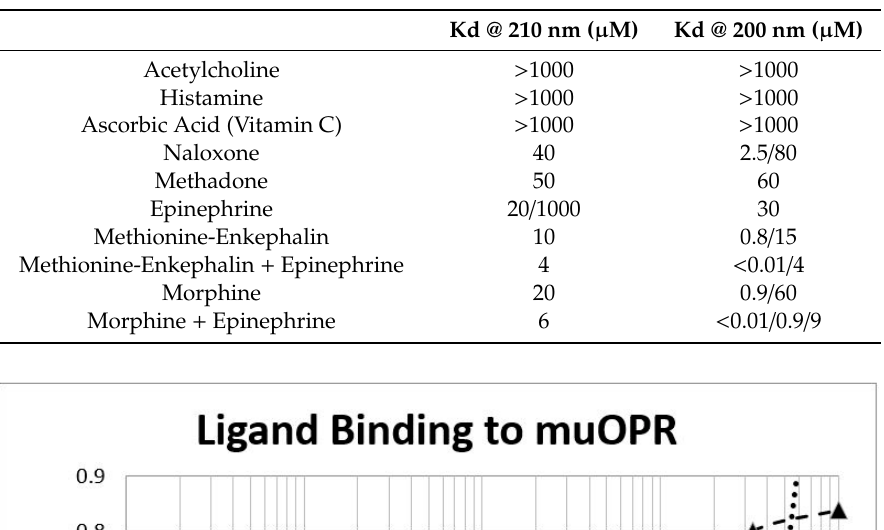
Table 3. Binding constants (micromolar) for various ligands to intact mu opioid receptors (some data from [56]). Some binding curves displayed evidence of high and low a ffi nity binding, indicated in the table by two or more Kd values separated by a slash. The presence of a question mark indicates that one of the curves is very small and possibly not reliable.